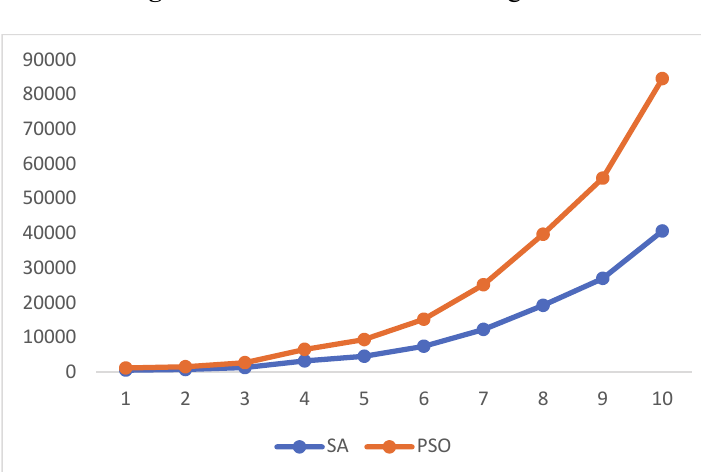
Fig. 4. Execution Result of SA Algorithm